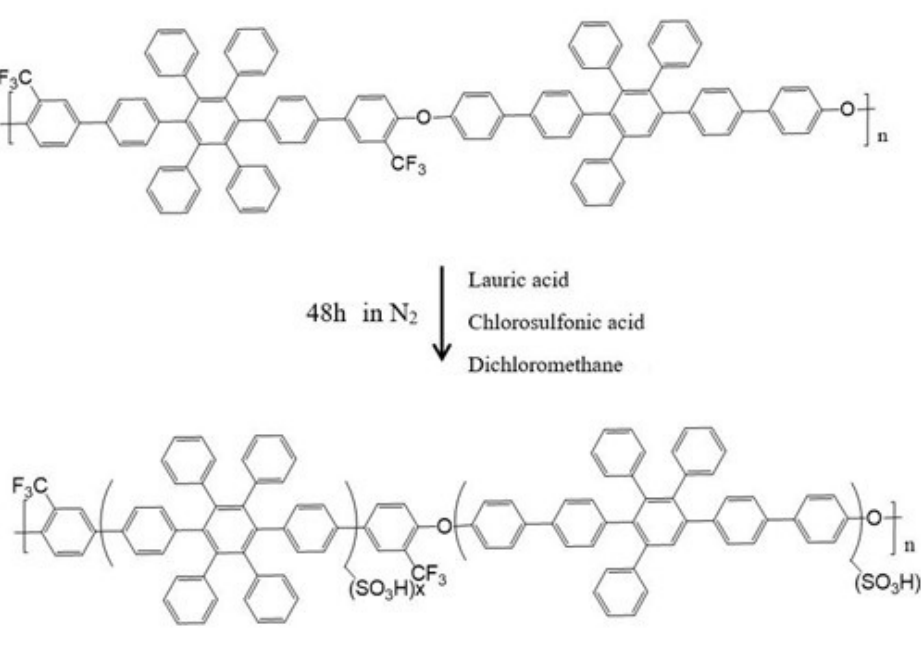
Figure 1. Diagram of SA8 polymer